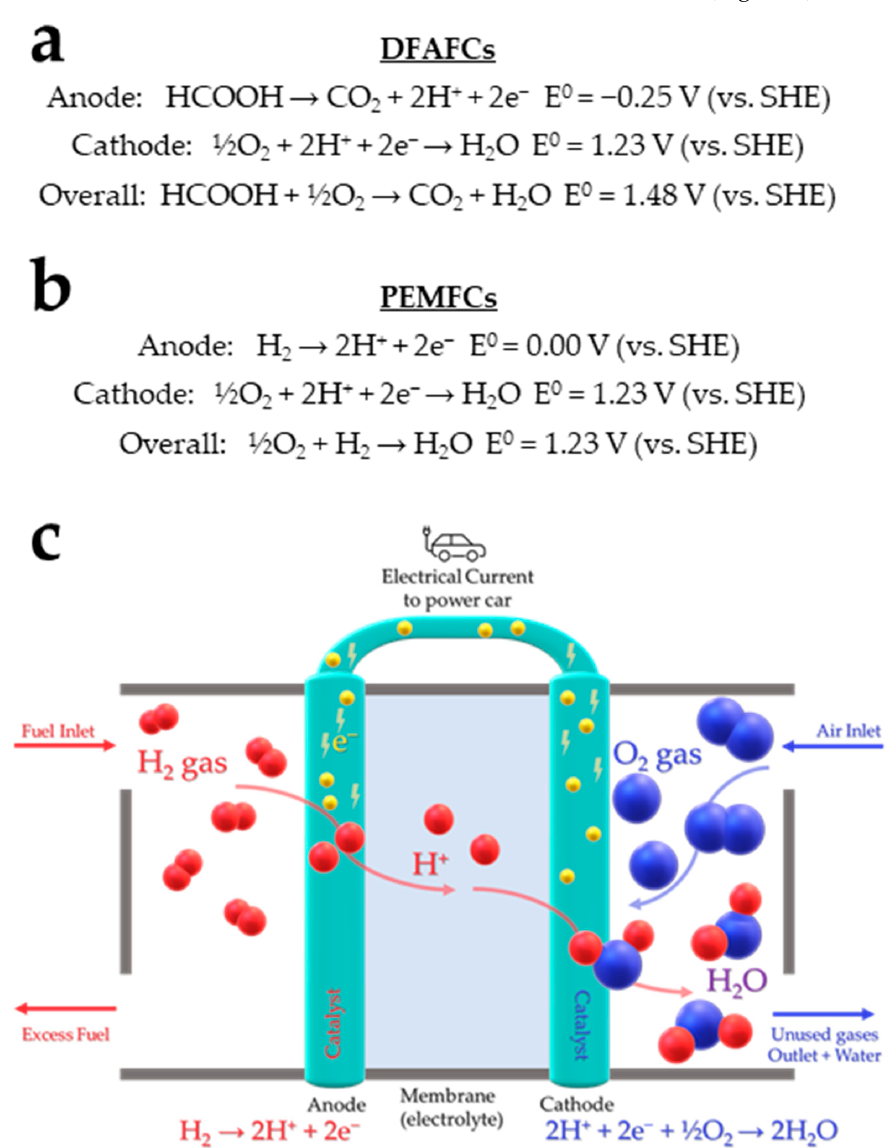
Figure 4. The reactions that occur at the anode and cathode of ( a ) Direct Formic Acid Fuel Cells (DFAFC), ( b ) Proton-exchange membrane fuel cells (PEMFC), ( c ) Schematic representation of a PEMFC.